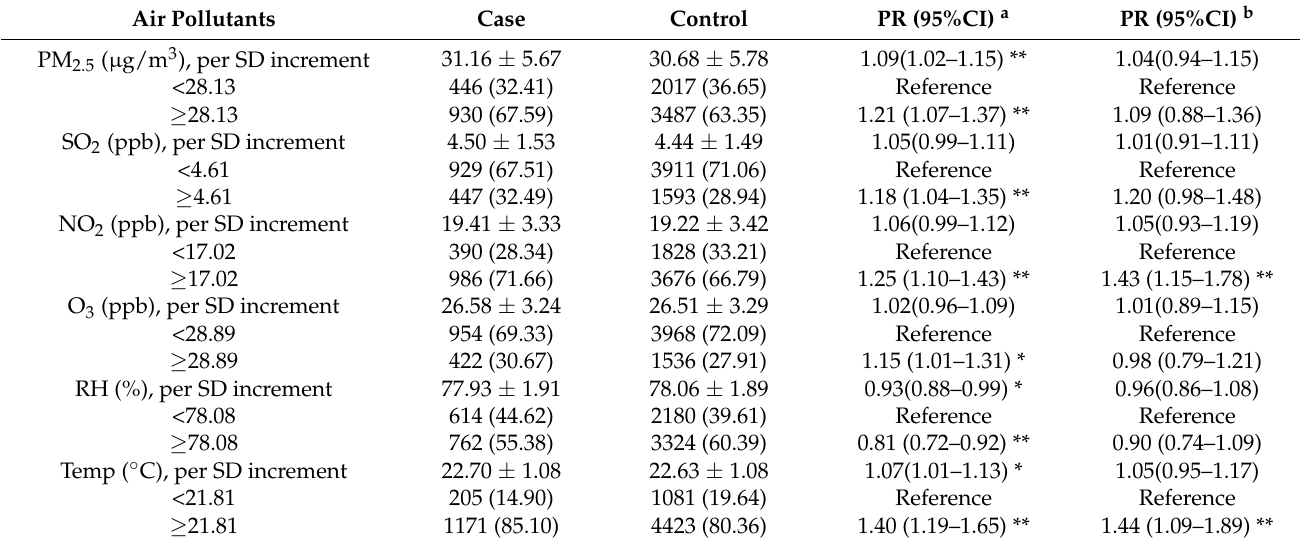
Table 3. The effects of various air pollutants on the risk of dry eye syndrome using logistic regression. Air Pollutants Case